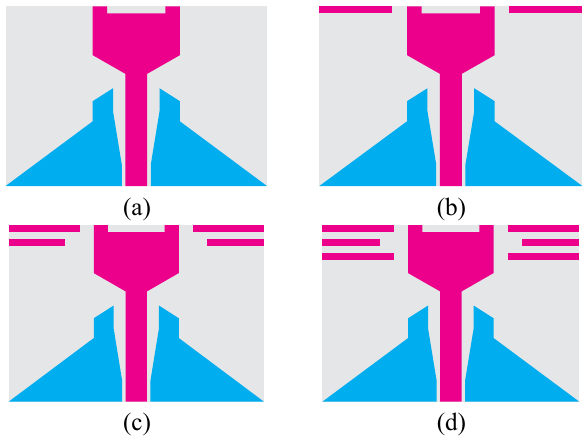
FIGURE 3. Simulated |S 11 | of ground plane design process for antennas shown in Fig. 2.